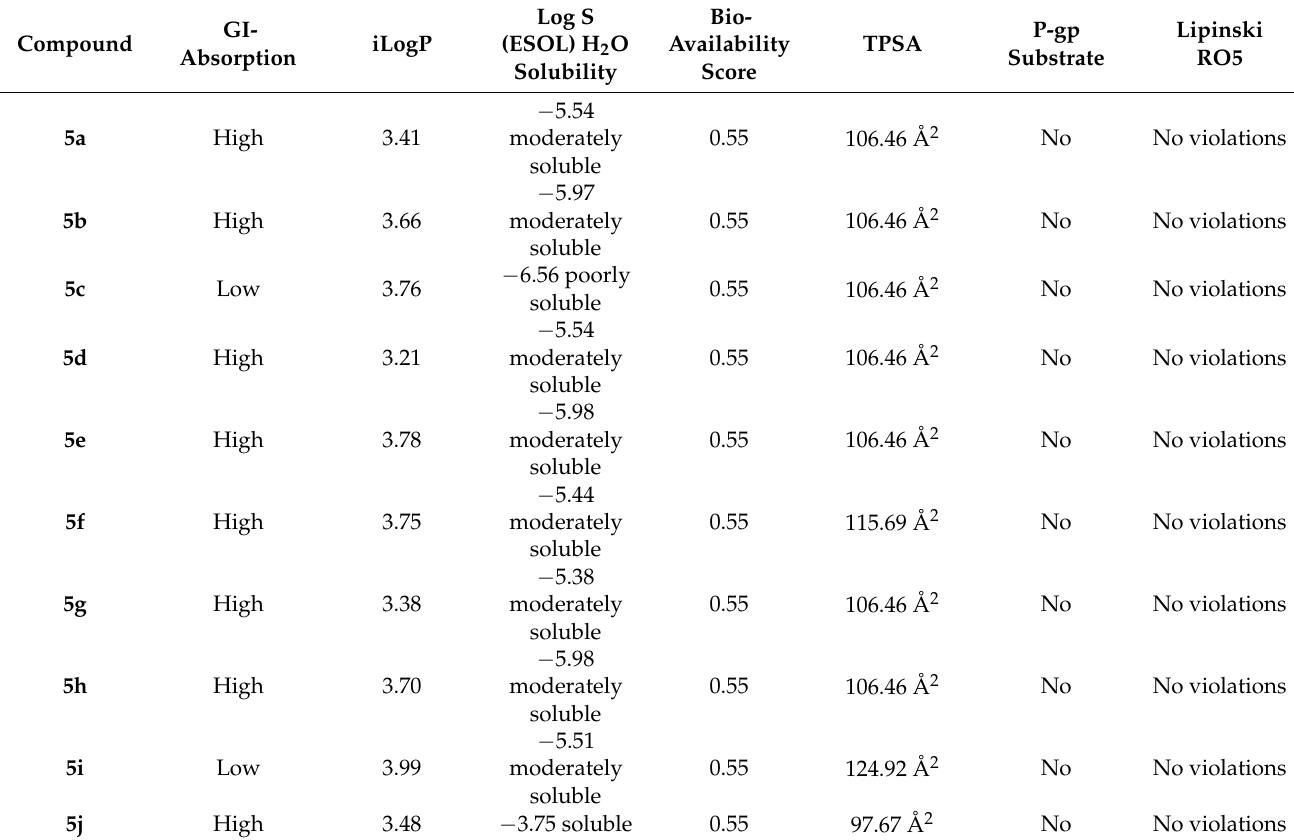
Table 5. ADMET and drug-likeness profiles of synthesized compounds 5a–j